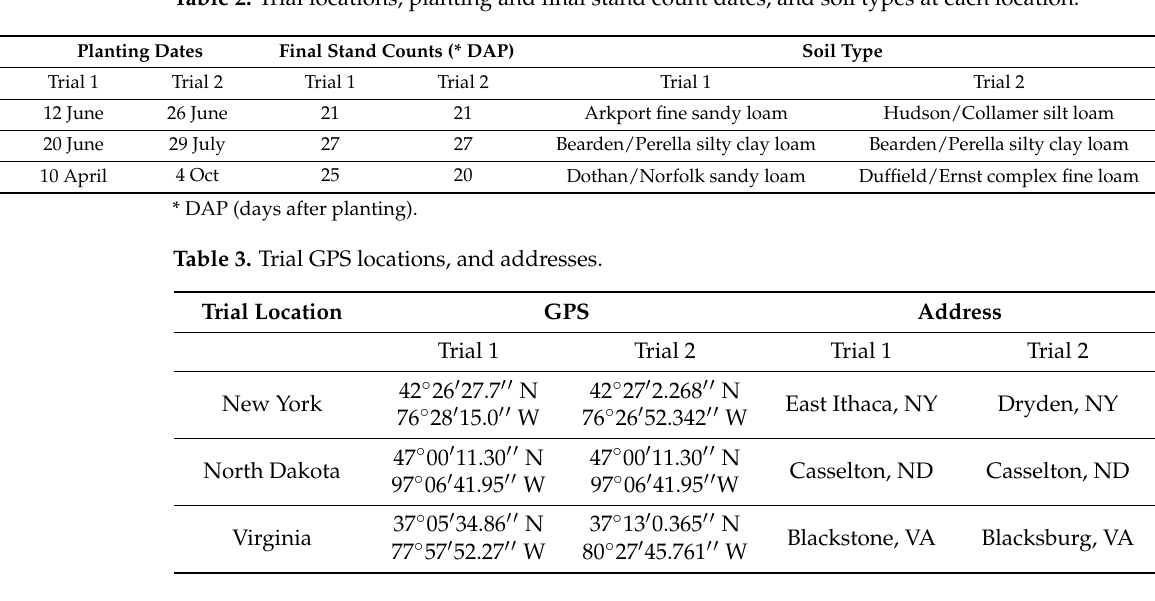
Table 2. Trial locations, planting and final stand count dates, and soil types at each location.